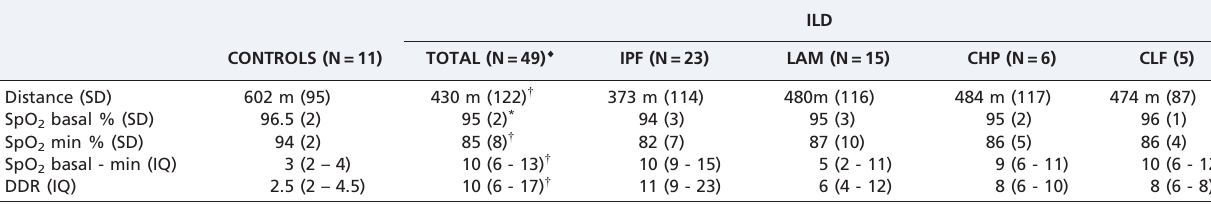
Table 2 - Six-minute walk test parameters in ILD patients and controls.